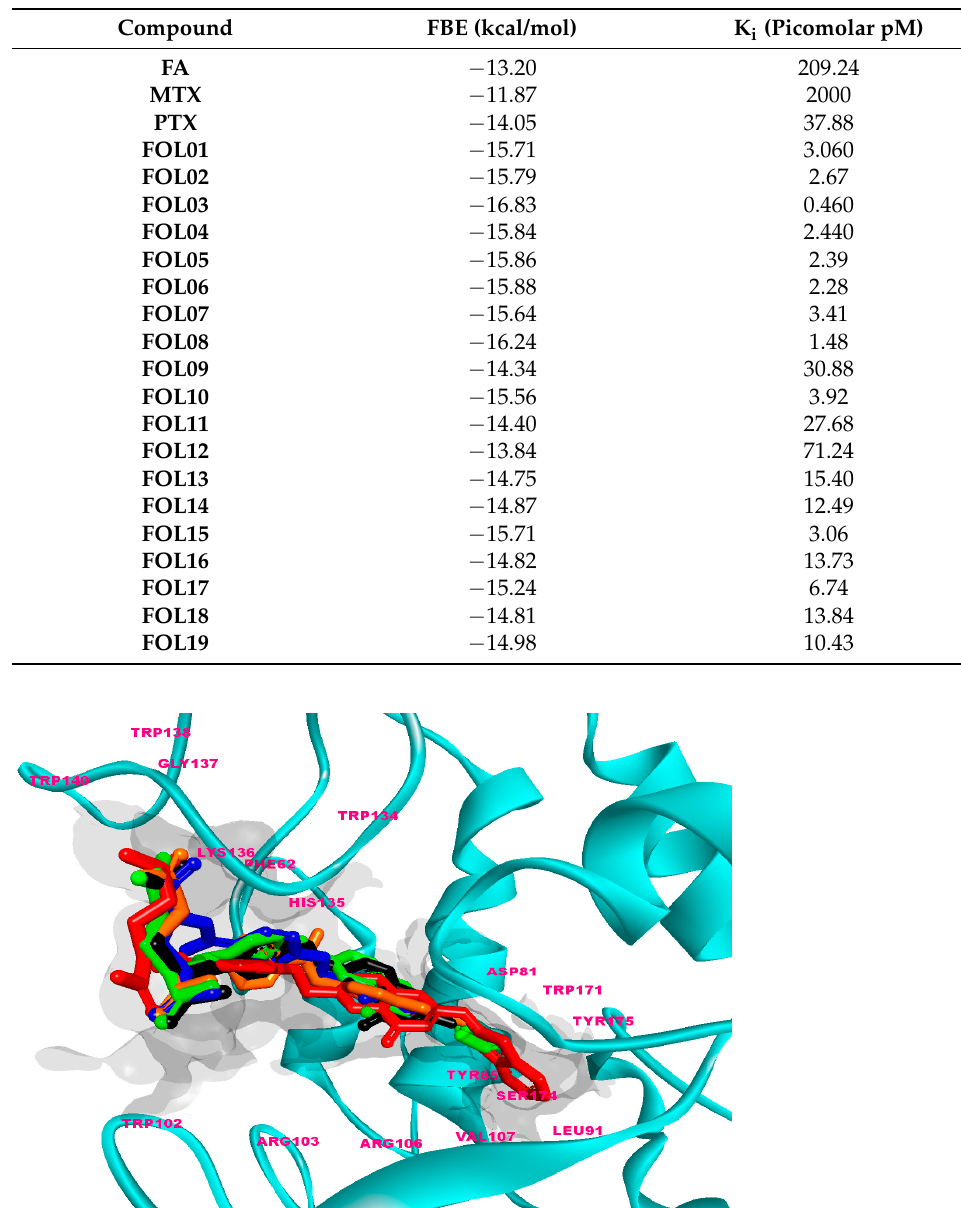
Table 1. Free binding energy (FBE), inhibition constant (K i ) of FA, MTX, PTX, and the 19 FA analogs.